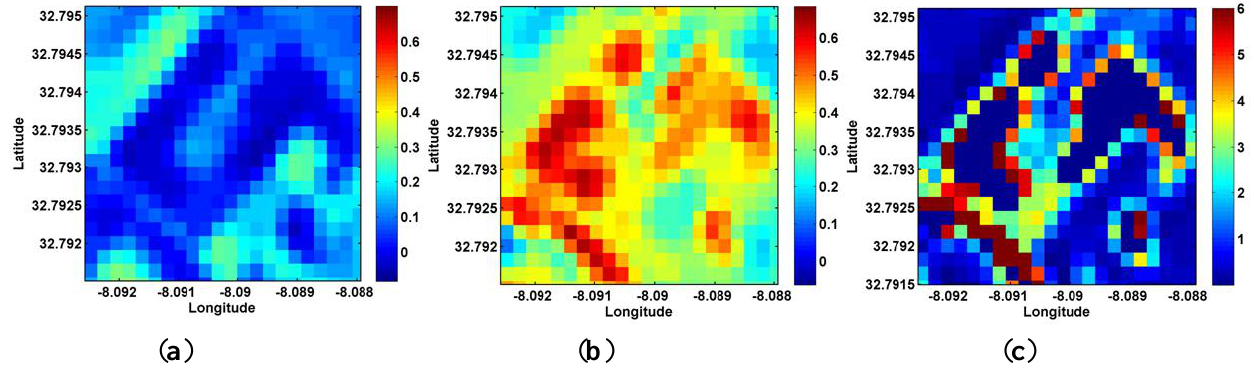
Figure 8. ( a ) HRVIR1 saturated pixels: ( a ) Red band (negatives values), ( b ) NIR band (red color maximum value, yellow color blooming) and ( c ) Blooming effect on LAI values; Faregh district on 10 June 2013.